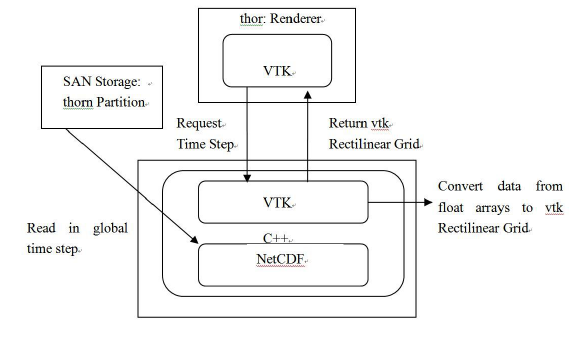
Figure 1: Flow of global data to VTK